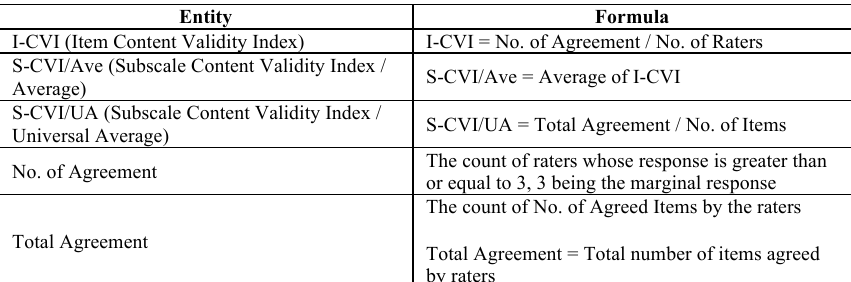
Table 2. Key Formulae for Content Validity Testing